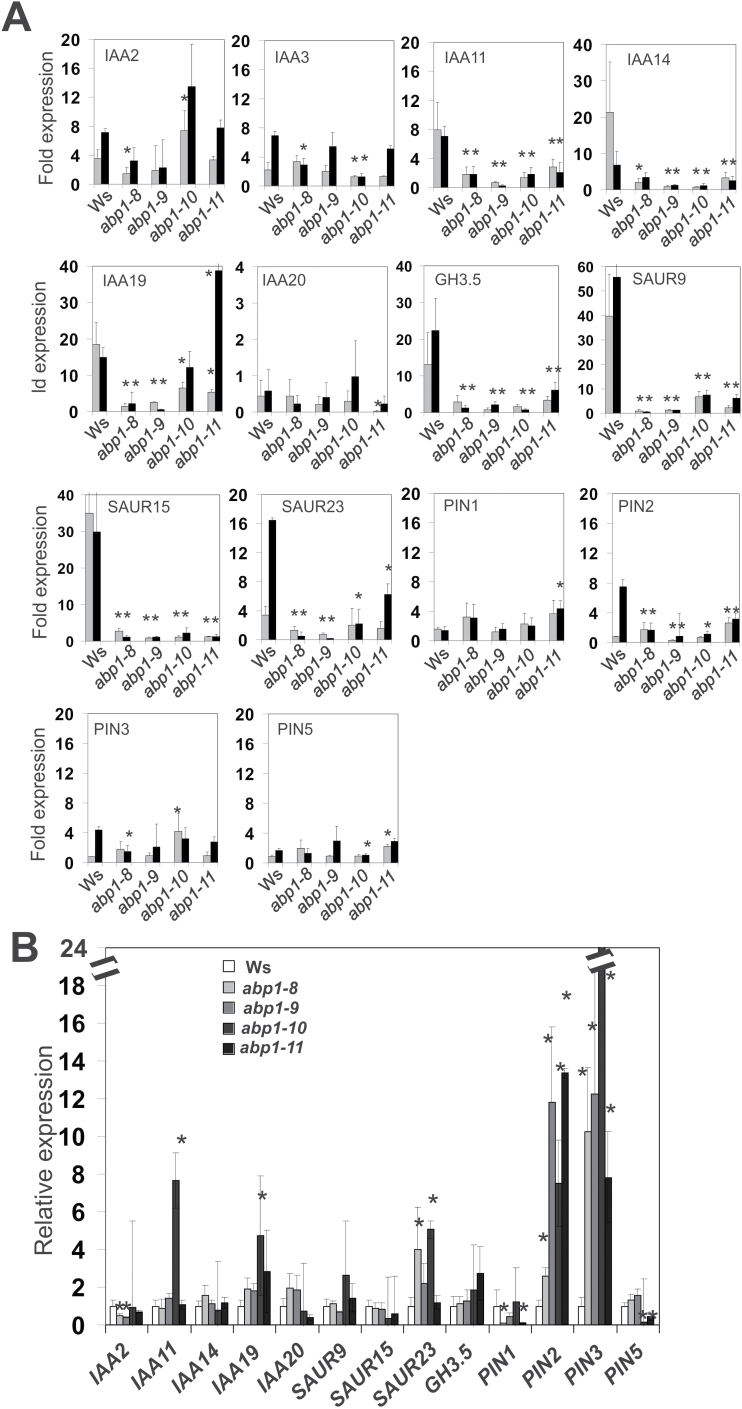
Expression of early auxin genes and several PIN genes in 14-day-old light-grown seedlings. Seedlings were either treated with 10 µM IAA in (A) (grey bars: 10min, black bars: 30min) or mock in (B). qRT-PCRs were from three biological replicates with three technical replicates for each gene. Statistical analysis was performed as described by Livak and Schmittgen (2001) and verified using the method of Pfaffl et al. (2002). At t=0min fold expression was set as 1 for the wt in (B). Asterisks indicate significant difference to the wt (* P<0.05; ** P<0.01).